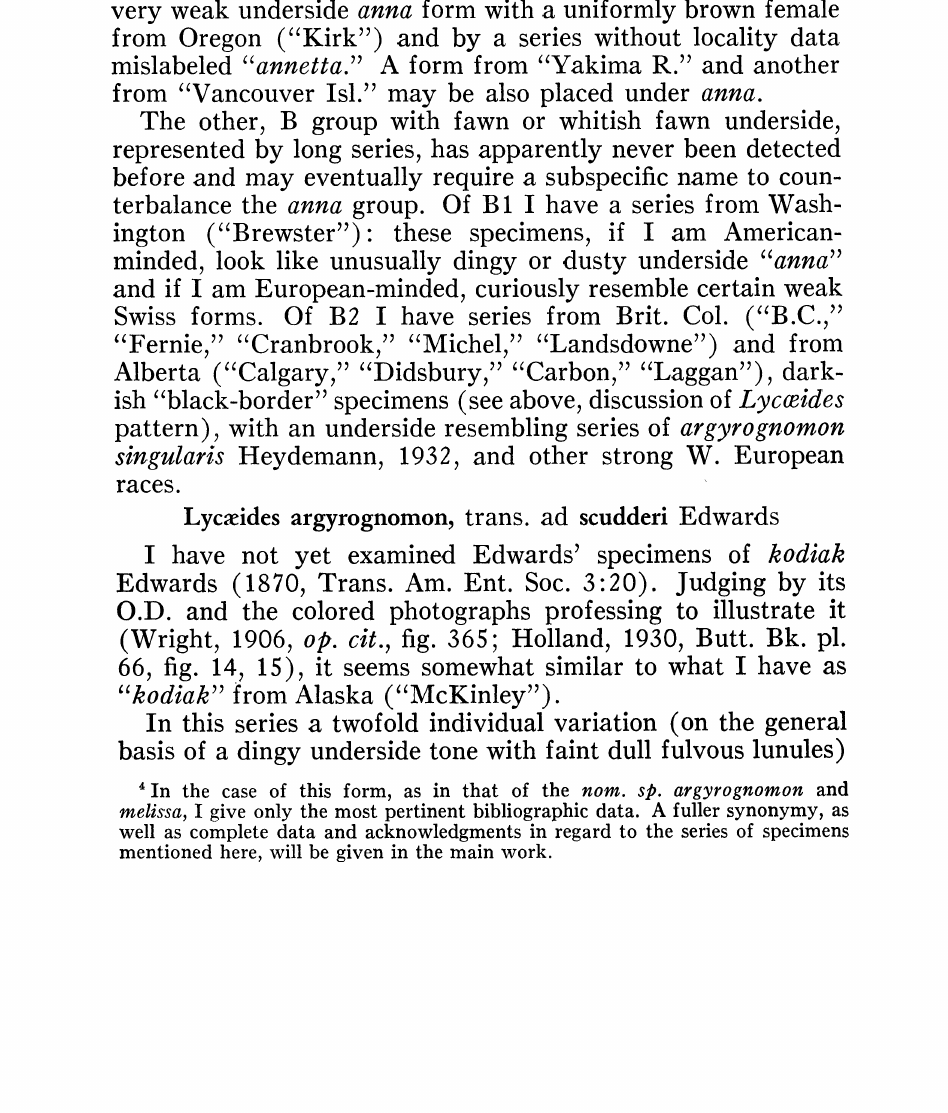
fig. 4, male, fig. 5., female; Stempffer, 1933, Bull. Soc. Ent. France 102" 111, fig. 2, male